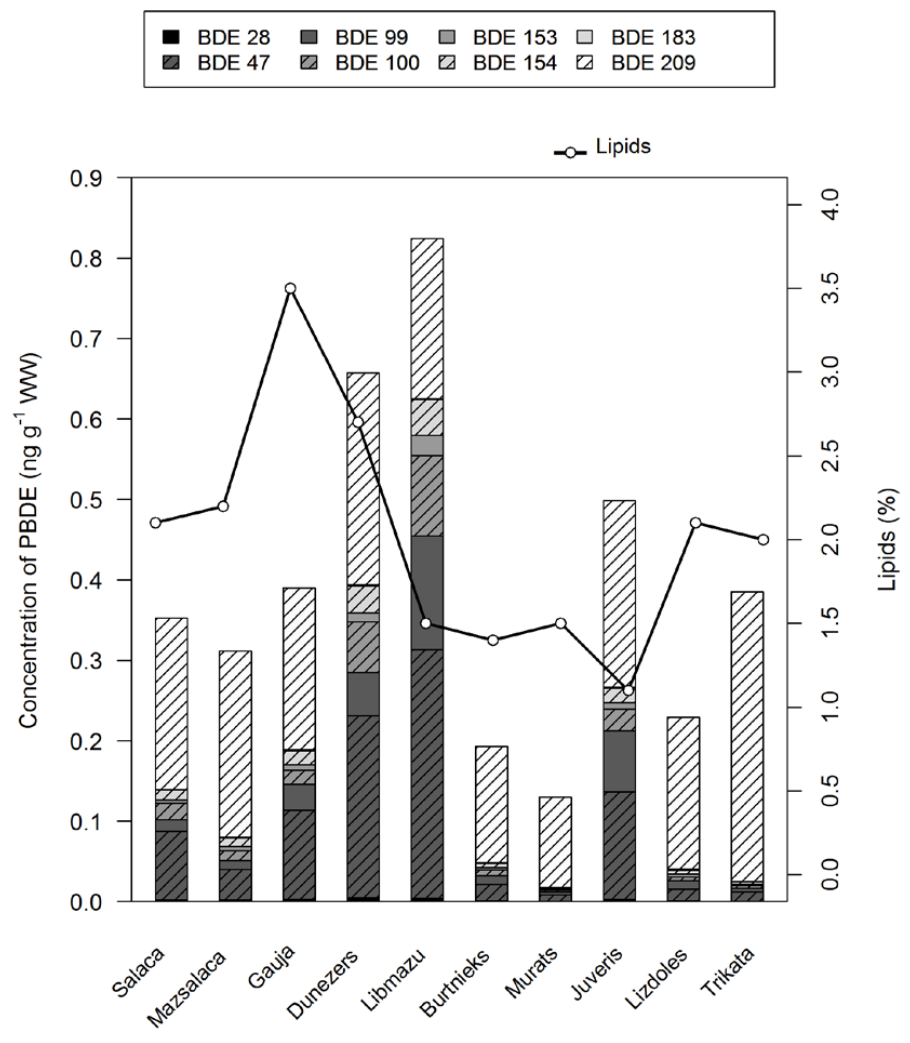
Figure 5. Concentrations of PBDEs and lipid content in tissues of European perch ( Perca fluviatilis ) from rivers and lakes of Latvia.